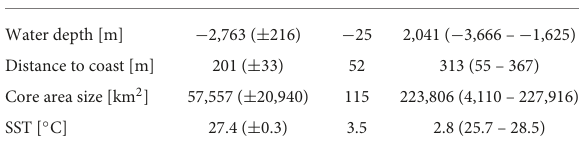
TABLE 4 Mean values, coefficient of variation (CV), and range in values for water depth, distance to coast, core area size, and sea surface temperature (SST) in ten individual tracks of solitary olive ridley females in the Eastern Tropical Pacific. Mean ( ± S.E.) CV Range